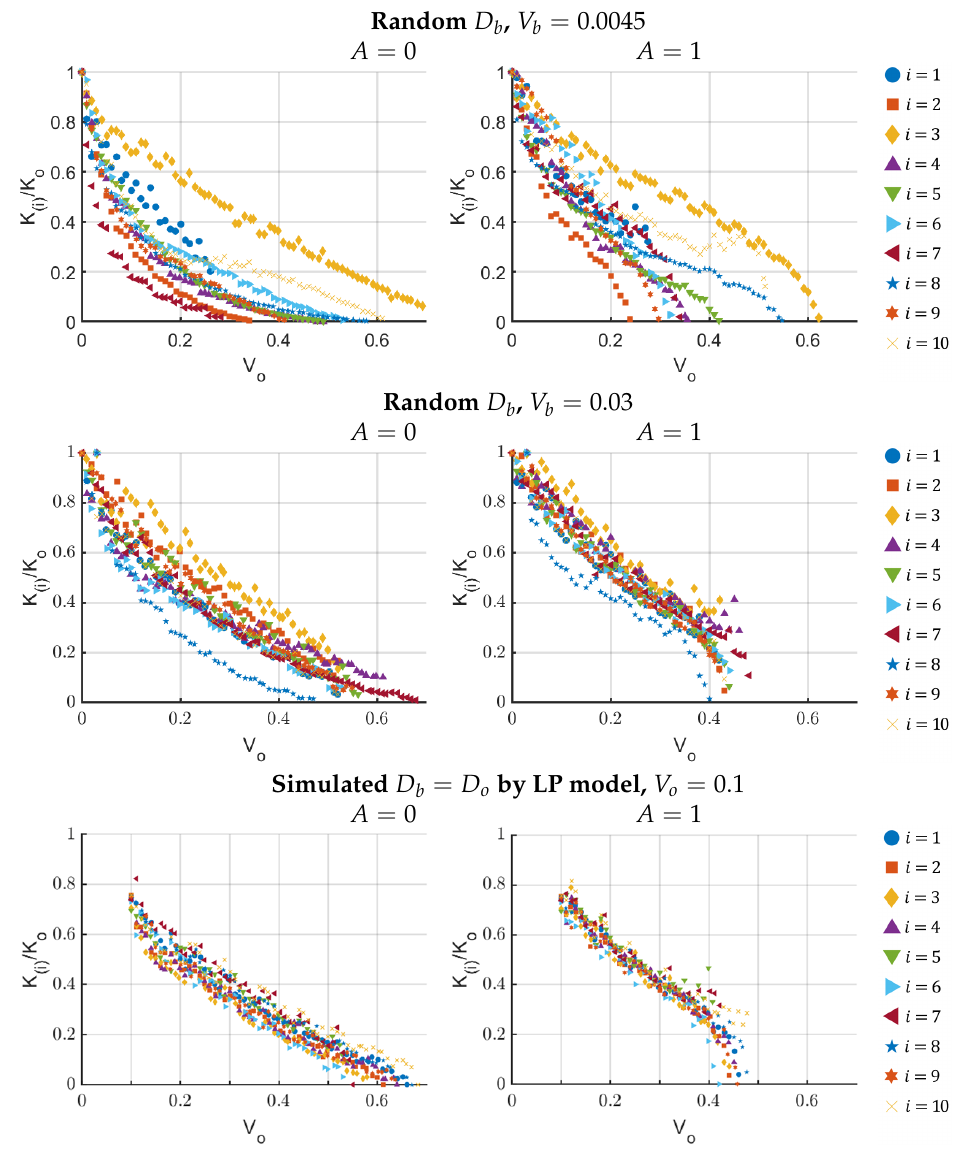
Figure 14. Dependence of K ( t ) on V o ( t ) with the BN model discussed in Section 6.1.1. Results are shown for 10 realizations of geometries, selected out of I = 100, generated with V b and A , as